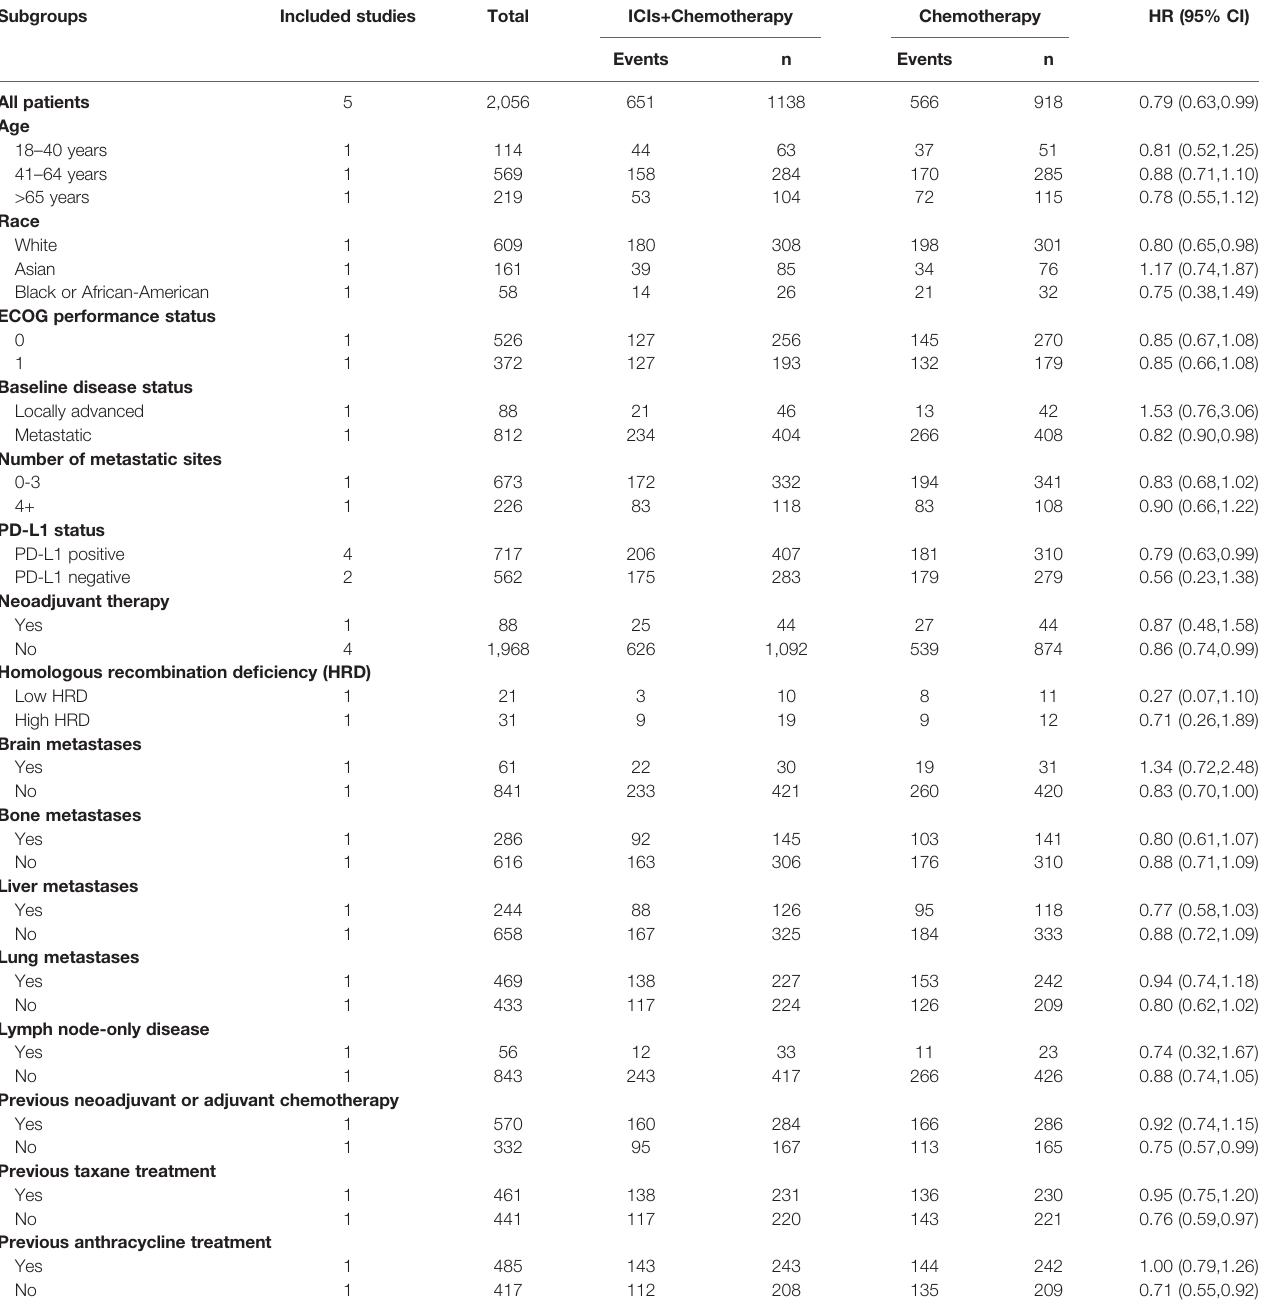
TABLE 2 | Subgroup analysis for